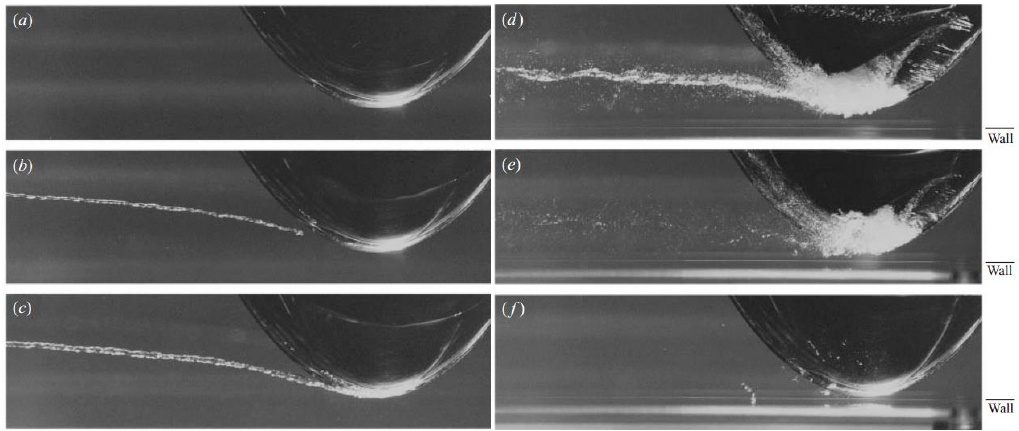
Figure 5. Visualizations of tip-vortex cavitation for different tip clearances: ( a ) 50 mm; ( b ) 20 mm; ( c ) 13 mm; ( d ) 4 mm; ( e ) 2 mm; ( f ) 0.5 mm [12].